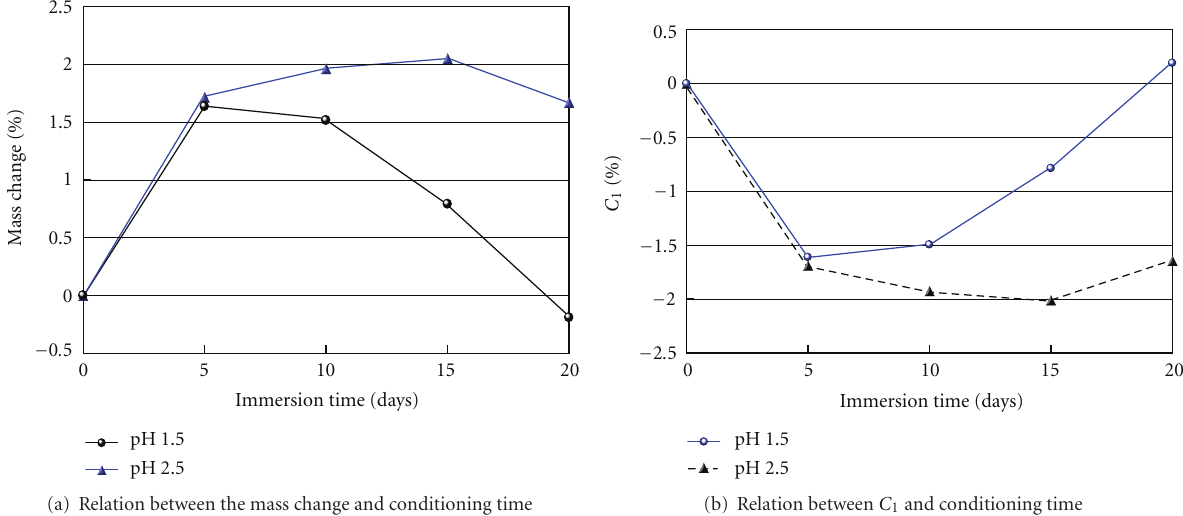
Figure 3: Relation between void volume and immersion